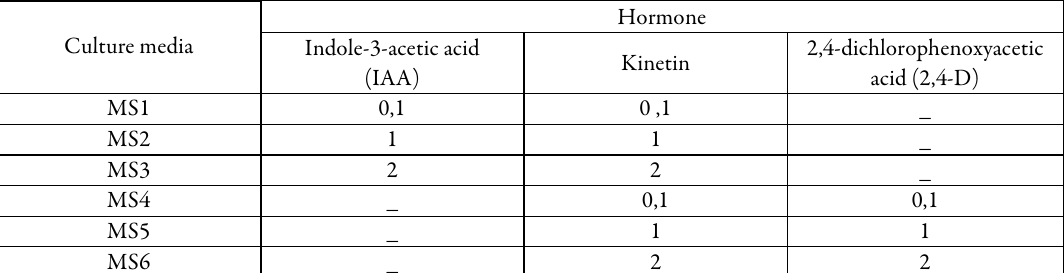
Table 1. Hormonal combinations added to Murashige and Skoog (MS) media for the initiation of callogenesis in Cicer arietinum